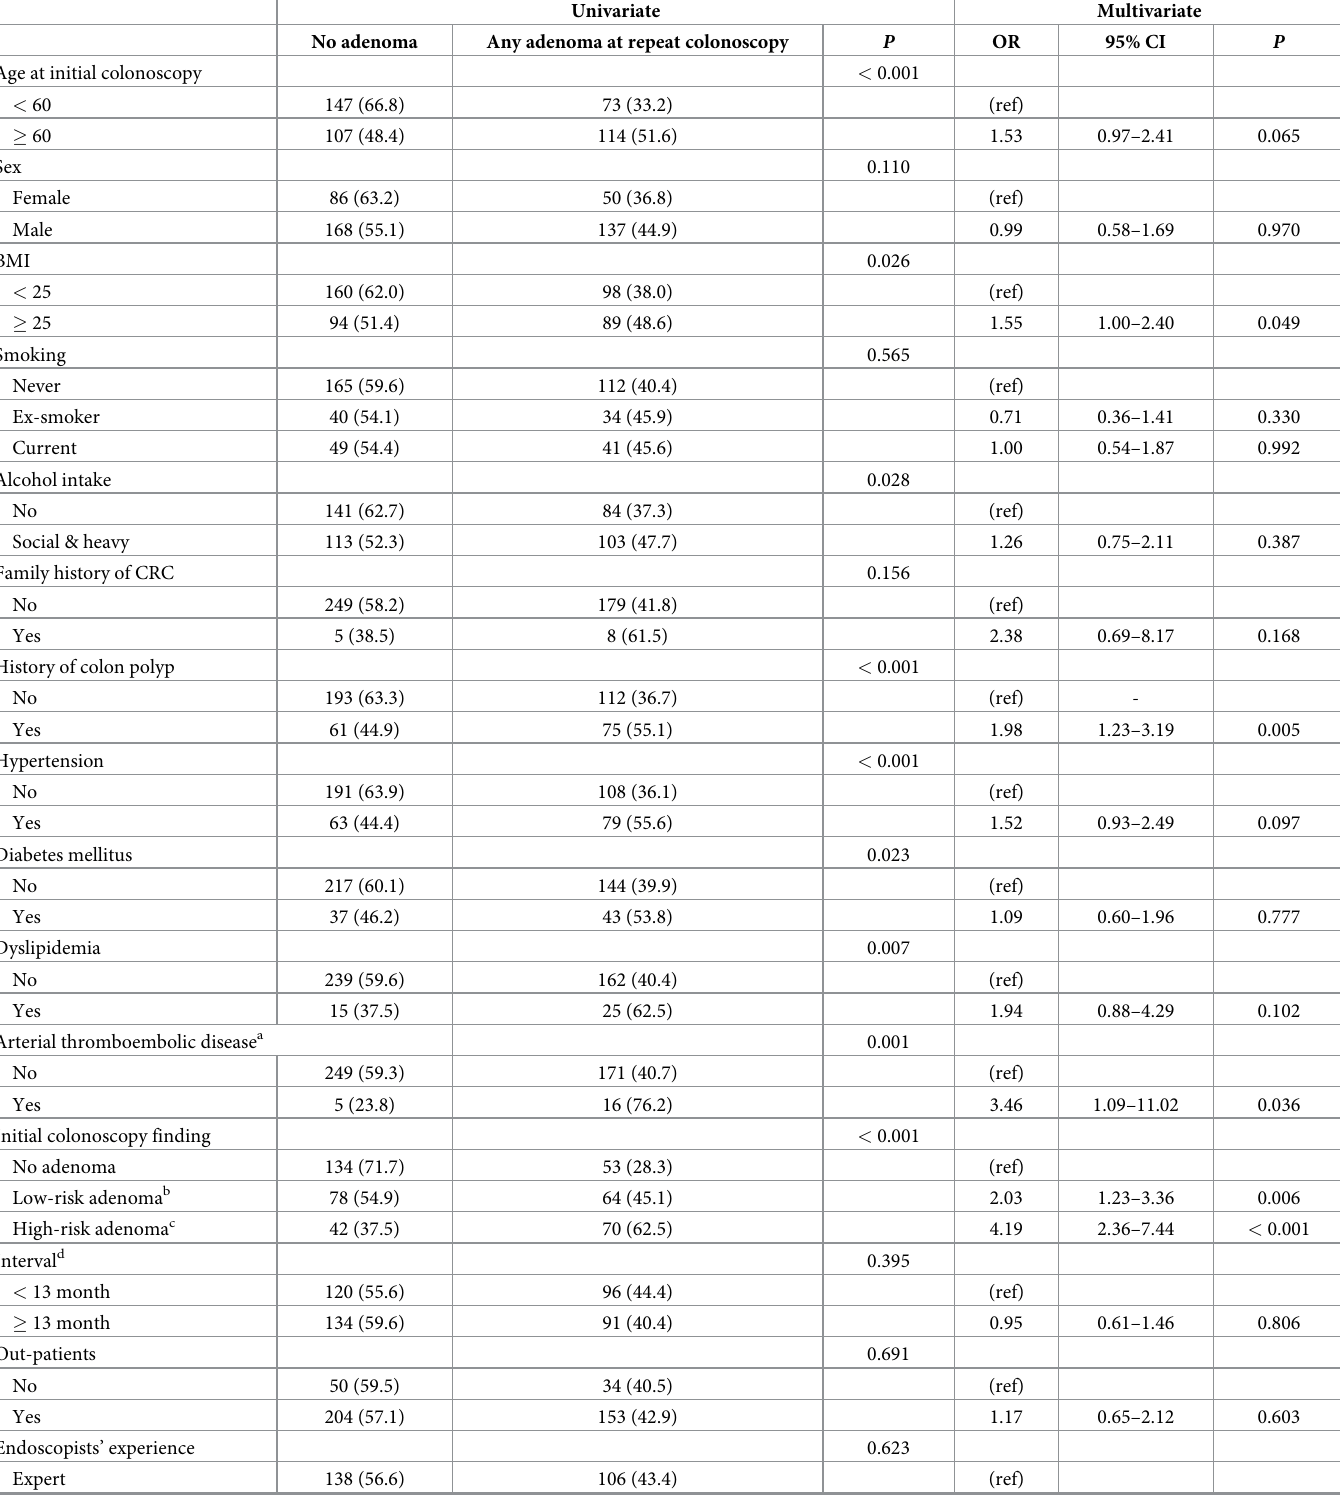
Table 3. Clinical factors at initial colonoscopy predictive of any missed adenoma of repeat